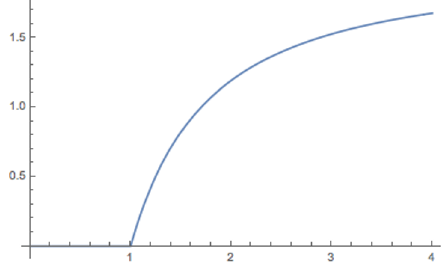
Figure 1 . The plot of Imδ M / ( R s p t π )